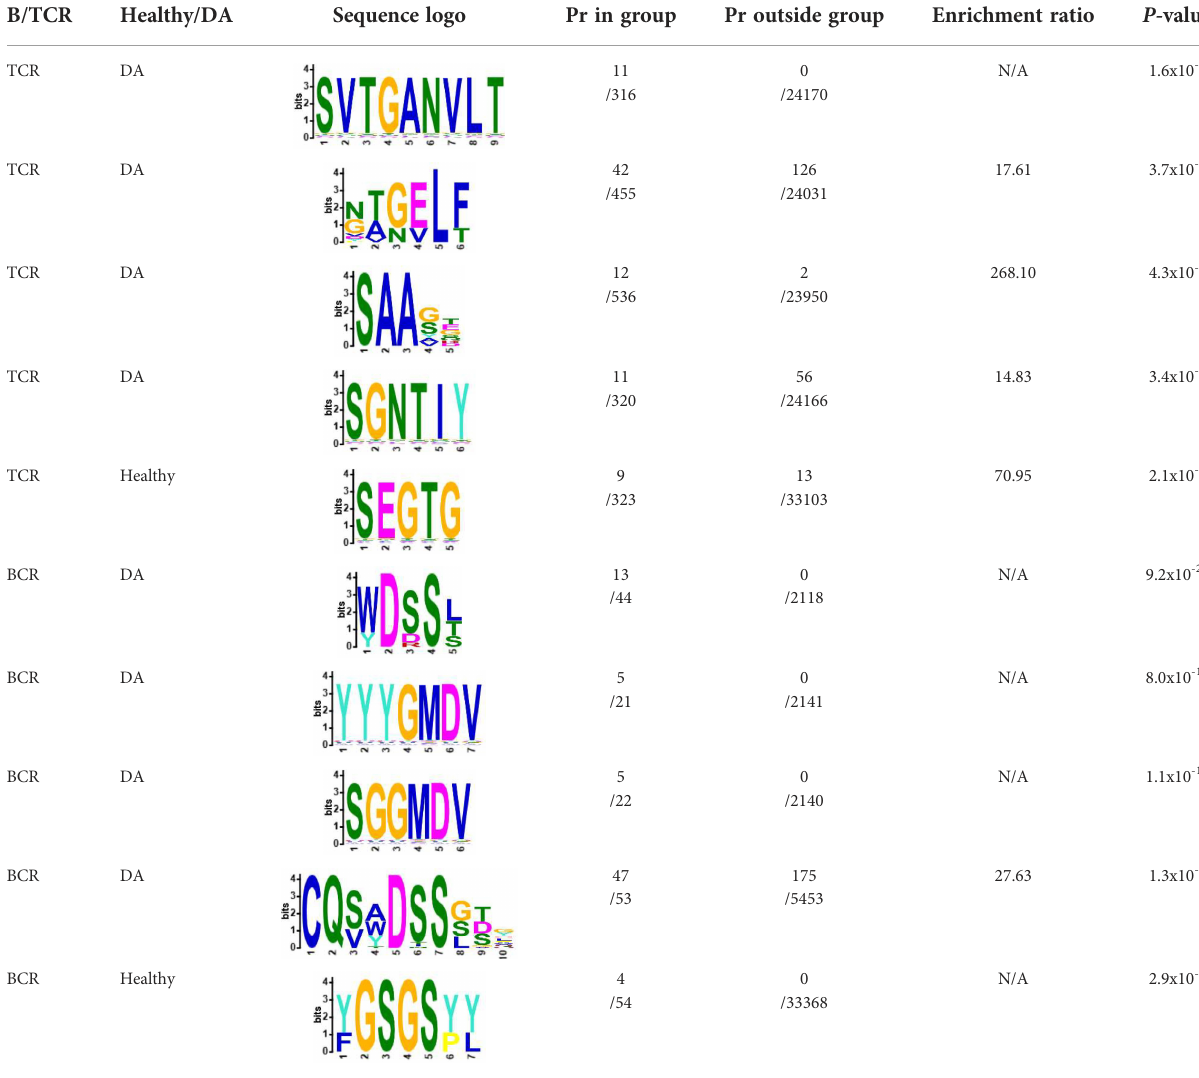
TABLE 2 Motifs discovered from clusters of healthy and DA B and T cell